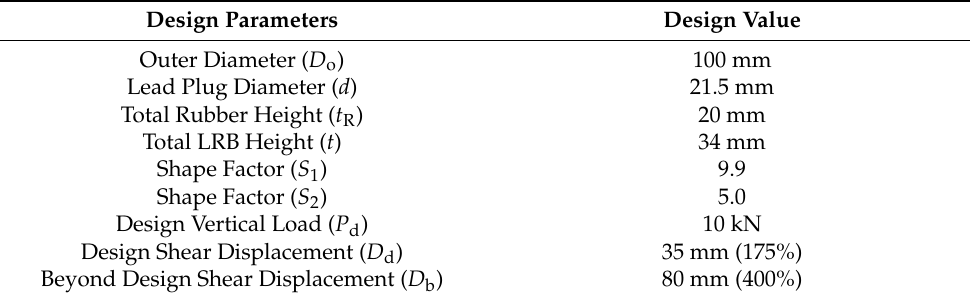
Table 1. Summary of LRB design parameters [21].